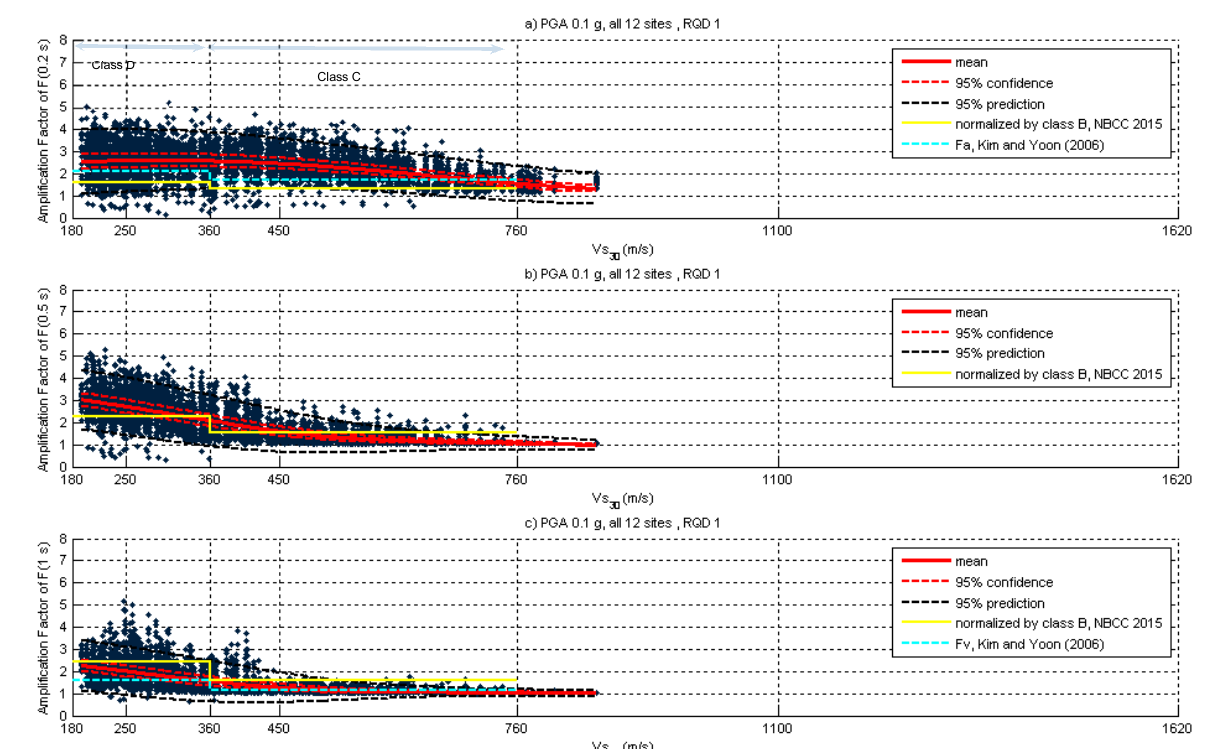
Figure 13. Amplification factors as a function of V s30 for periods of ( a ) 0.2 s, ( b ) 0.5 s, and ( c ) 1.0 s (RQD = 1, PGA = 0.1 g).